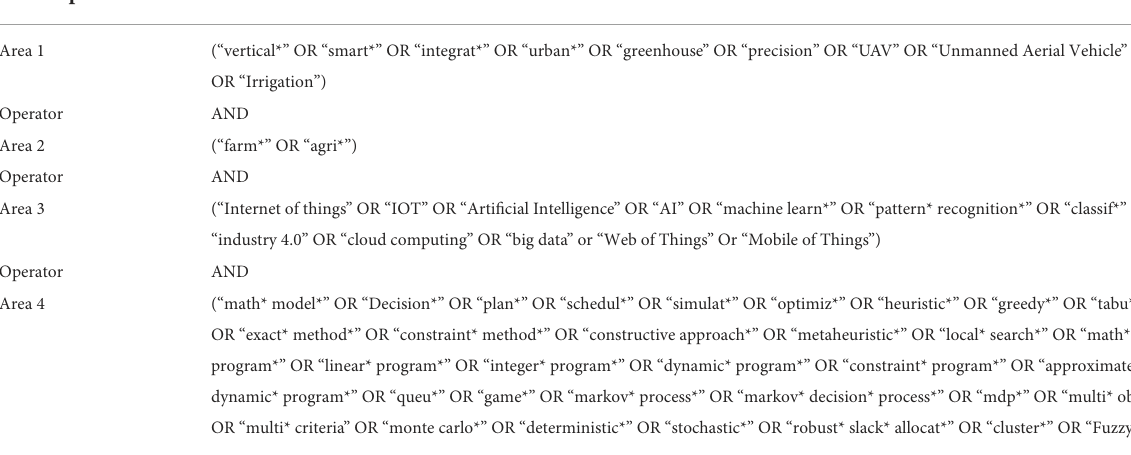
TABLE 1 Terms used for Scopus database